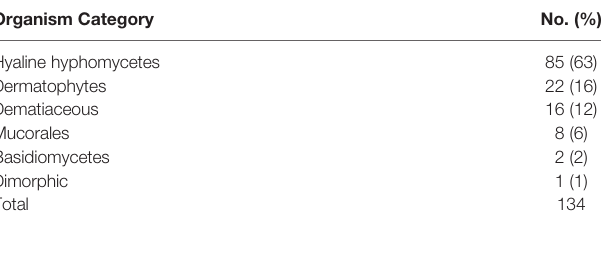
TABLE 1 | Categorization of organisms included in study.